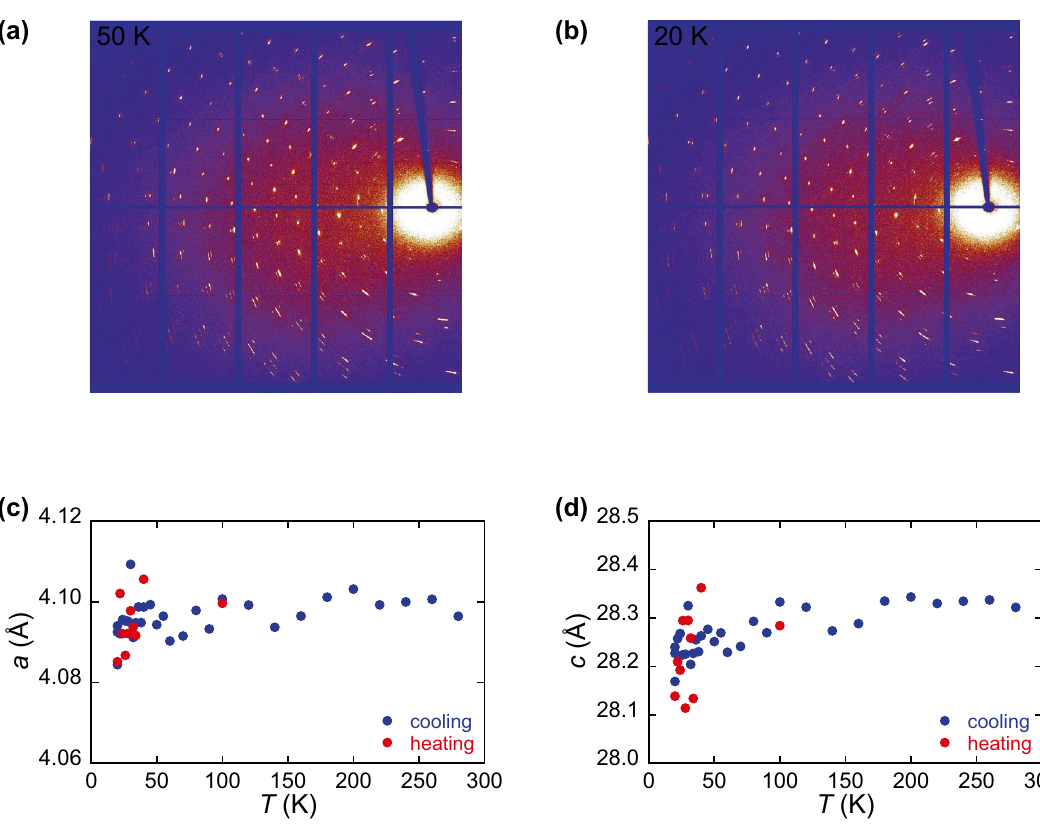
Figure 2. SC-XRD patterns obtained at ( a ) 50 K and ( b ) 20 K. Temperature dependence of lattice parameters of